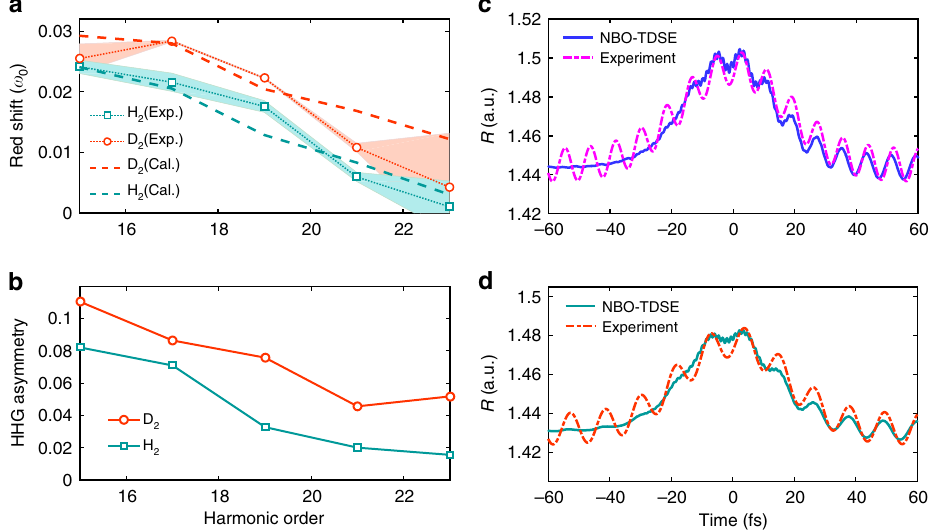
Fig. 4 Measured and calculated frequency shifts and nuclear motions of H 2 and D 2 . a Measured and calculated red shift Δ ω in MHOHG with respect to harmonics of Ar as a function of the harmonic order. b The HHG asymmetry coef fi cients η calculated for H 2 and D 2 . η ( ω ) > 0(<0) means the harmonic emission is more pronounced at the trailing (leading) edge of the laser pulse. Squares and circles are for H 2 and D 2 , respectively. c Calculated (solid line) and experimentally retrieved (dash-dotted line) nuclear vibration of H 2 . d Same as c , but for D 2 . Shaded areas in a represent the standard deviation of nine independent